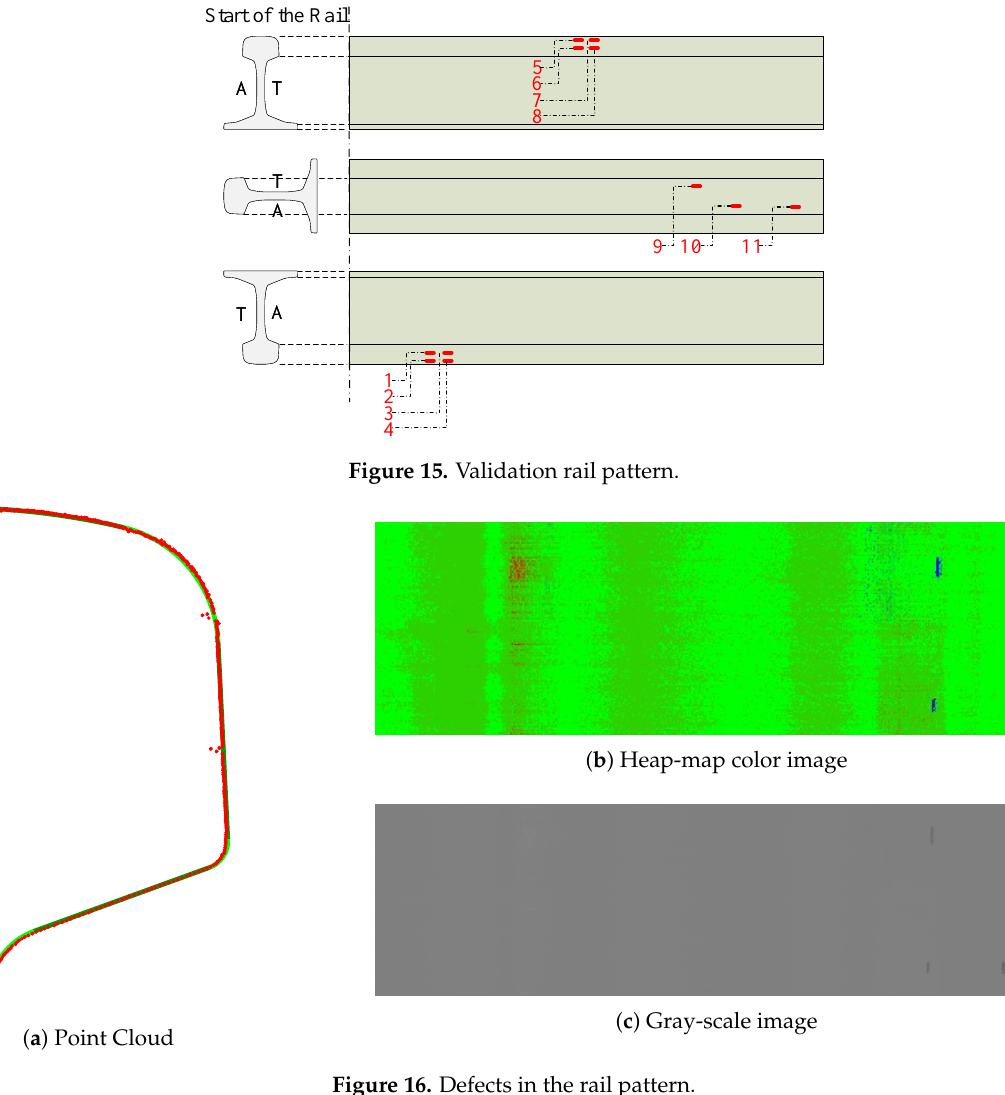
Figure 16. Defects in the rail